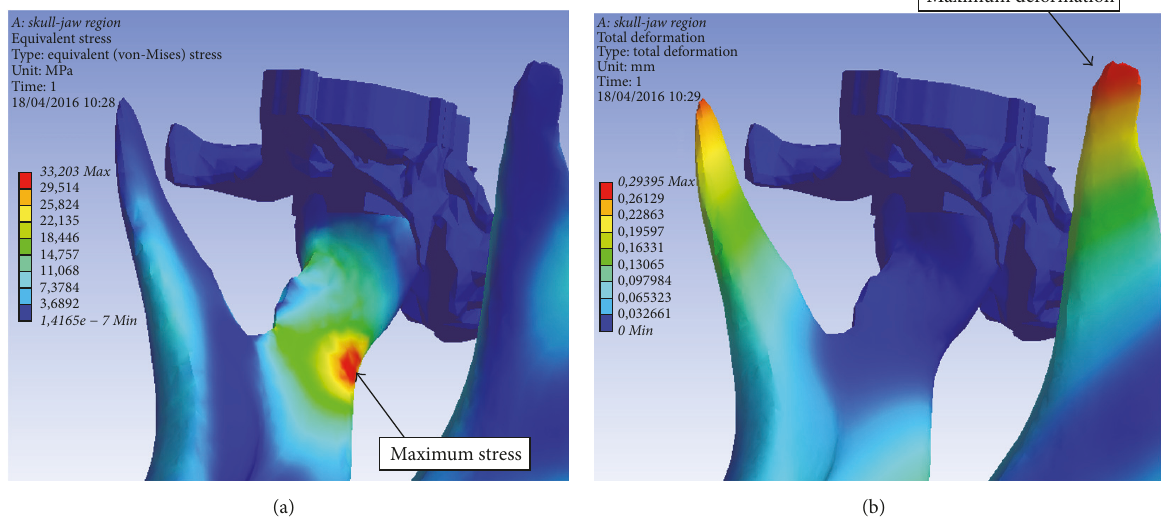
Figure 6: Stress distribution (a) and strain distribution (b) in skull-jaw assembly with rigid articular disc.